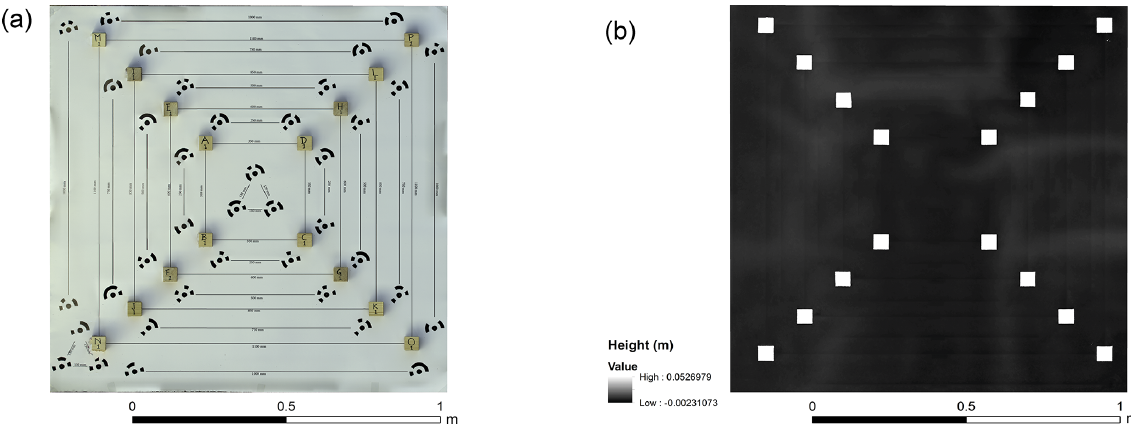
Figure 5. (a) Orthophoto of error evaluation chart. Coded scale bars represent horizontal checkpoints. Wooden blocks denote vertical checkpoints. (b) DEM of the error evaluation